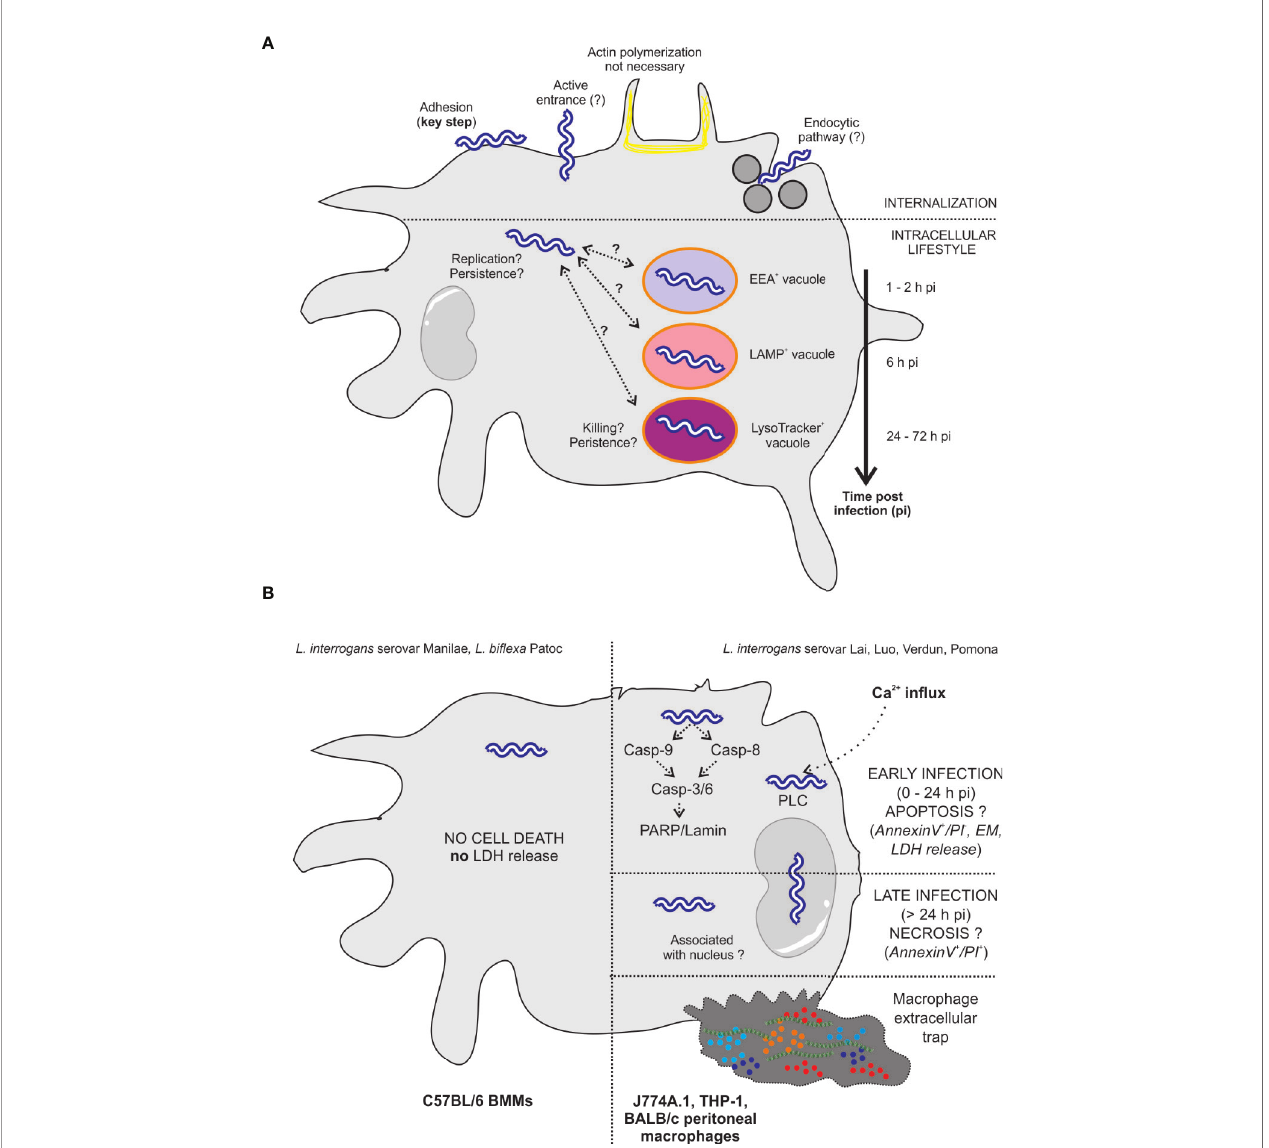
FIGURE 2 | Intracellular localization of L. interrogans and effect on cell death. (A) The internalization of leptospires is highly dependent on adhesion to the cell surface (25). The entrance mechanism is not clearly established since it does not seem to involve actin polymerization, suggesting an entrance mechanism other than phagocytosis (18, 25, 26). Viability seems to be essential since formalin- fi xed bacteria do not enter the cells (18). The endocytic pathway could potentially be involved in the internalization of leptospires since inhibition of this pathway in macrophages drastically reduced the number of intracellular bacteria (18). Once inside the cells, leptospires are found free in the cytosol in human and murine macrophages. In addition, some authors describe that leptospires are found in EEA1-, LAMP-, and LysoTracker-positive compartments using colocalization (20, 24). Colocalization seems to be extended over time, which may suggest the arrest of potential phagosomes/ autophagosomes at several stages. In human cells, leptospires appear to be replicative (20). However, in murine cells, the overall number of leptospires seems to be constant or diminished over time (20, 24), with the unique observation that live bacteria are still found at 72 hpi, suggesting their persistence. (B) L. interrogans serovar Manilae does not induce macrophage cell death upon infection of BMMs obtained from a C57BL/6 background (24). L. interrogans serovars Lai, Luo, and Verdun induce cell death by apoptosis/necrosis upon infection of J774A.1, THP-1, and BALB/c peritoneal macrophages (18, 21 – 23). However, not all the studies have completely correlating results, and some controversies are revealed in the literature. Additionally, some studies report that leptospires are associated with the nucleus (18,